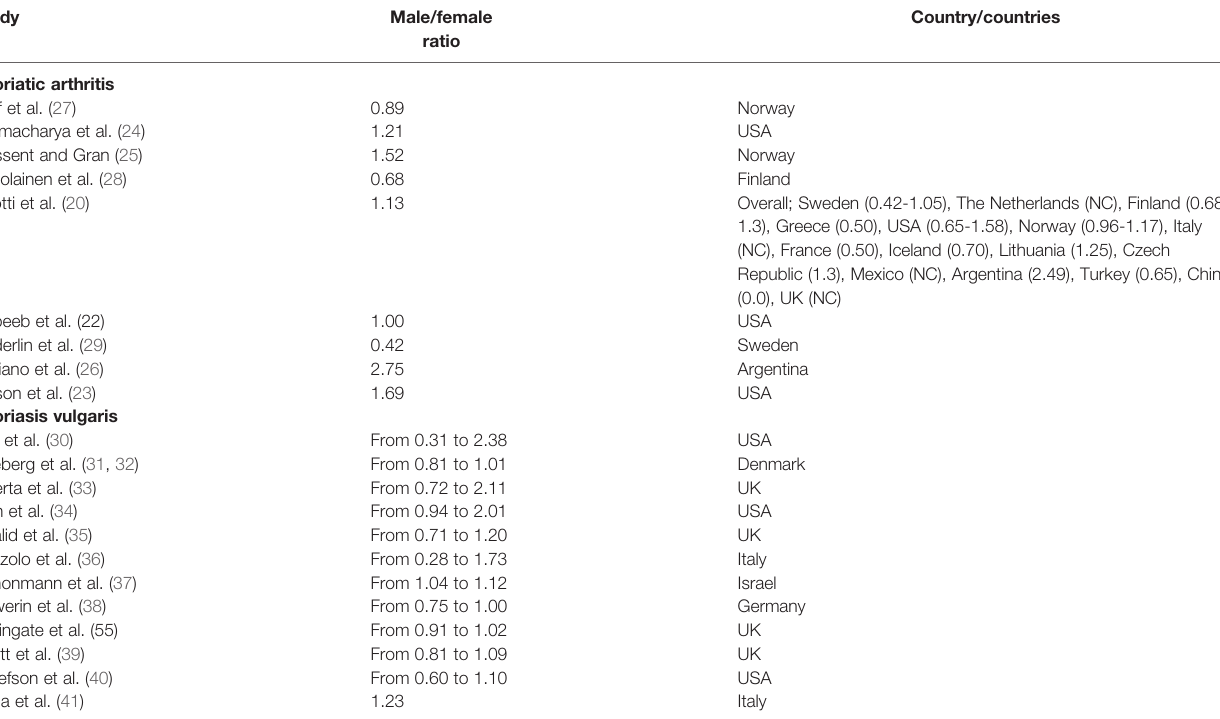
TABLE 1 | An overview of the major studies/surveys reporting sex-strati fi ed epidemiological rates of both psoriatic arthritis and